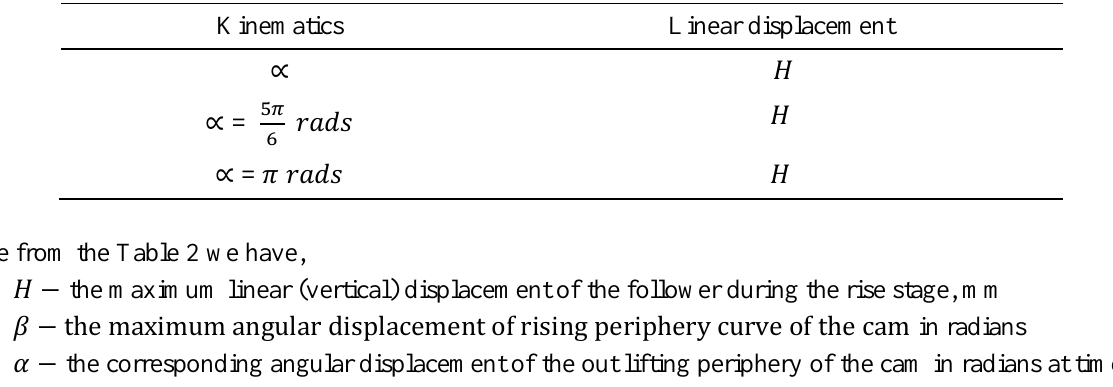
Table 2. Summary of the kinematic motion of the follower during the dwell